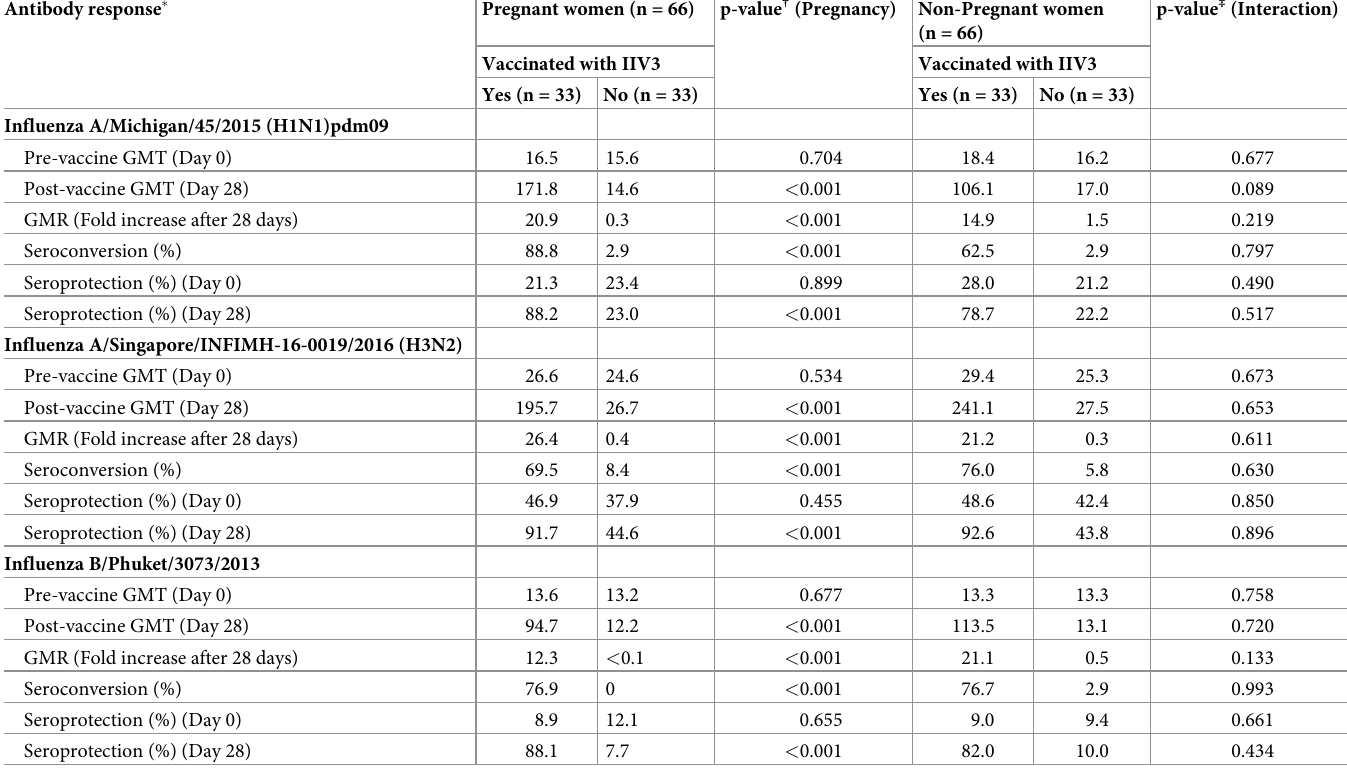
Table 2. Comparison of antibody responses against influenza vaccine strains among the study participants (N =